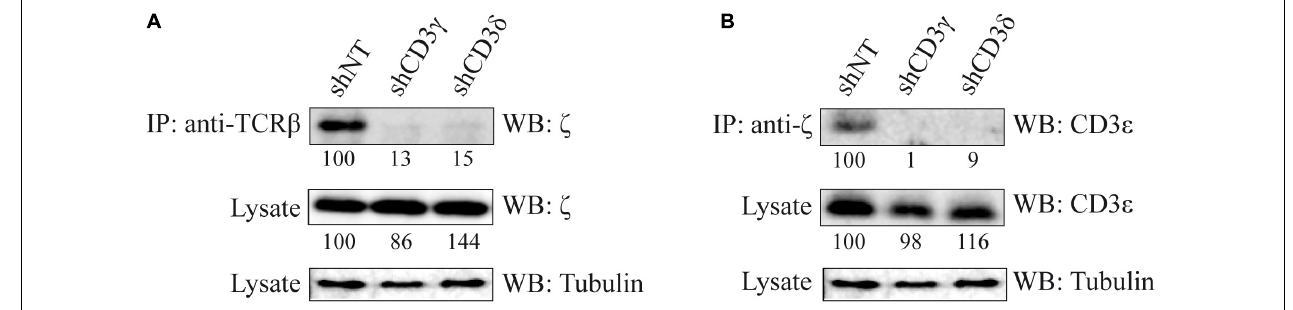
FIGURE 5 | Co-IP of ζζ /CD247 2 and other TCR chains in CD3G or CD3D KD T-cell lines. (A) Cells were lysed in Brij96V buffer, 3 mg of total protein was immunoprecipitated with anti-TCR β mAb (JOVI-1), and the immunoprecipitates and whole lysates were resolved in 15% SDS-PAGE gels and immunoblotted with antibodies against ζζ /CD247 2 (448) or alpha tubulin (Sigma). (B) Immunoprecipitation was done with anti- ζ and immunoblot with mAb against CD3 ε (Abcam) or α -tubulin (Sigma). Band analysis and numbers as in Figure 1 . The tubulin loading control is shared in (A,B) for illustrative purposes.